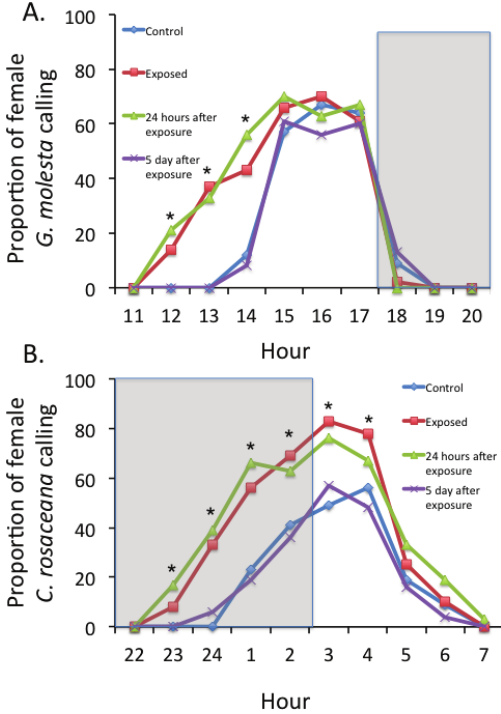
Figure 1. Proportion of female Grapholita molesta ( A ) or Choristoneura rosaceana ( B ) calling throughout the diel cycle under no pheromone exposure, during pheromone exposure, and 24 hours or 5 days following pheromone exposure. Significant ( p ≤ 0.05) differences between the proportions of female moths calling in the pheromone treatments are depicted by “ * ”. Shaded gray areas depict scotophase. n =